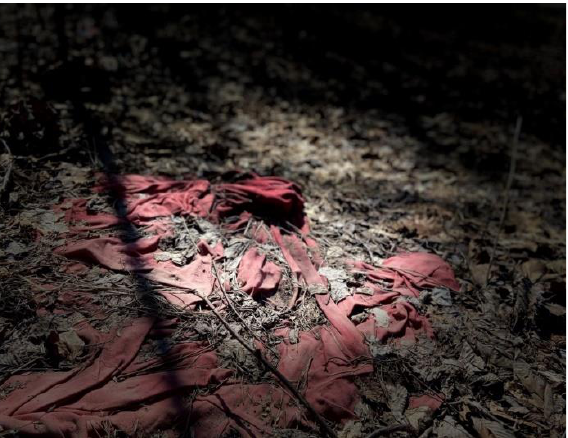
Figure 1. Sense of hopelessness and depression after experiencing repeated acts of domestic violence.